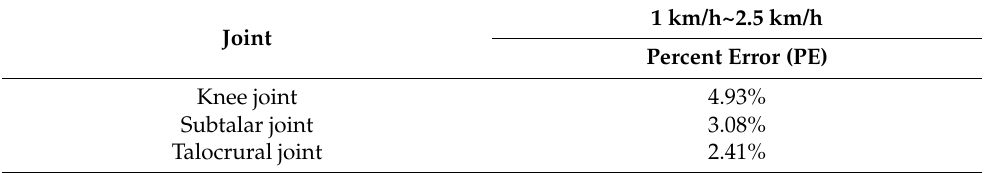
Table 10. Percent error (PE) of angle estimation simulation according to walking speed.